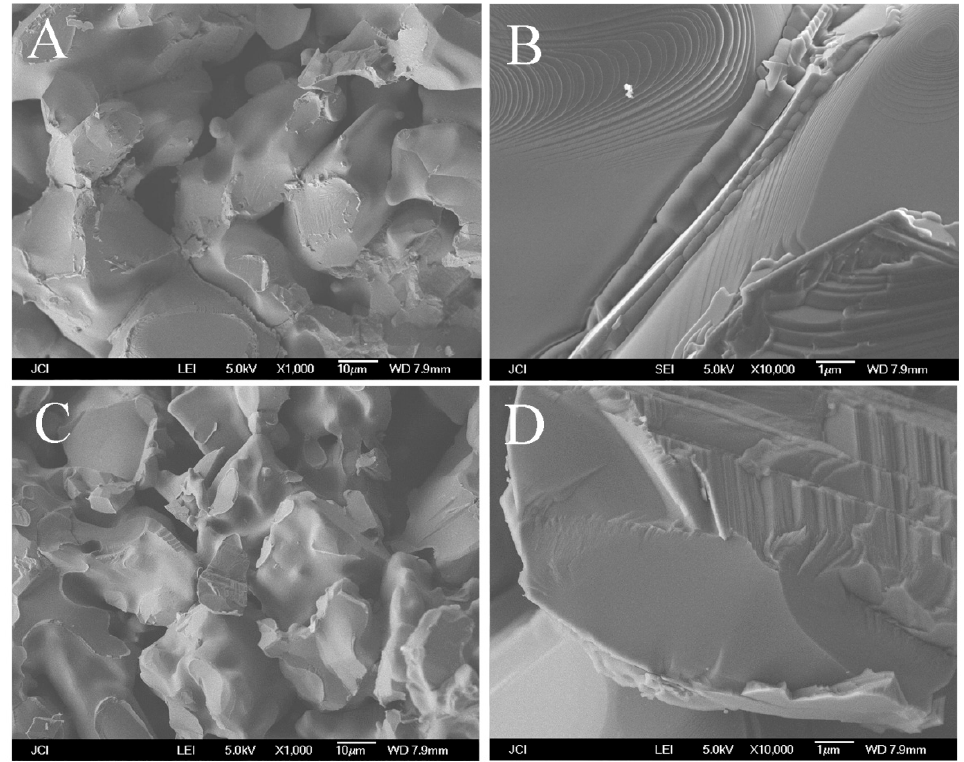
Figure 6. SEM images of the cross-section of the supports with ( A , B ) 2.0 wt.% TiO 2 added by in-situ precipitation and ( C , D ) 0.4 wt.%TiO 2 added by in-situ hydrolysis.